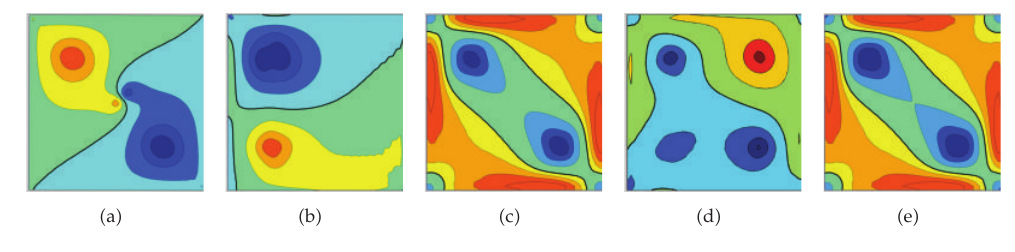
Figure 17: Error di ff erence.